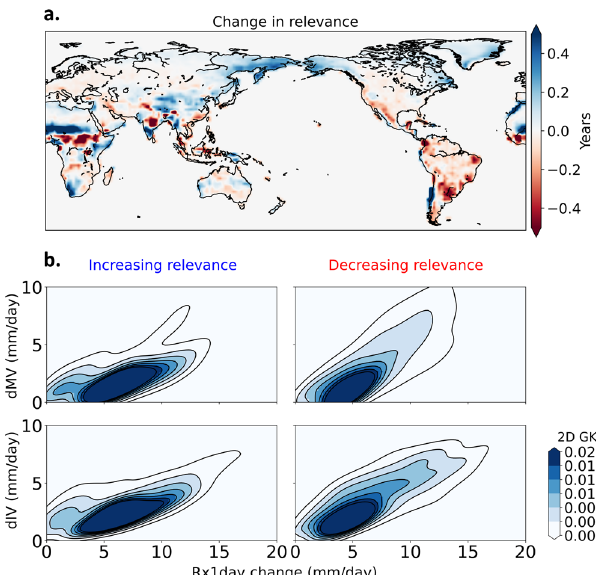
Fig. 2 Change in the relevance patterns learned by the neural network through time. a Multimodel average change of relevance maps between 2070 – 2099 and 1920 – 1949. Relevance is the contribution of each grid value to the neural network ’ s decision, obtained using layer-wise relevance propagation (see “ Methods ” ). b Multimodel ensemble-mean change in annual maximum daily precipitation (Rx1day) vs change in intermodel variability of Rx1day, (dMV, top panels), change in Rx1day vs change in internal variability of Rx1day (dIV, bottom panels), between 2070 – 2099 and 1920 – 1949. Two-dimensional Gaussian kernel density (2D GKD) estimation is shown. Left panels show results for grid cells where relevance increases with time in panel ( a ) and right panels show results for grid cells where relevance decreases. Internal variability is calculated as the standard deviation of Rx1day time-series and intermodel variability is calculated as the standard deviation of mean Rx1day from all models for each time period. Prior to the calculation of internal variability, the forced Rx1day trend at each grid cell was removed by regressing onto 41-year lowess fi ltered annual global-mean surface temperature 85 .